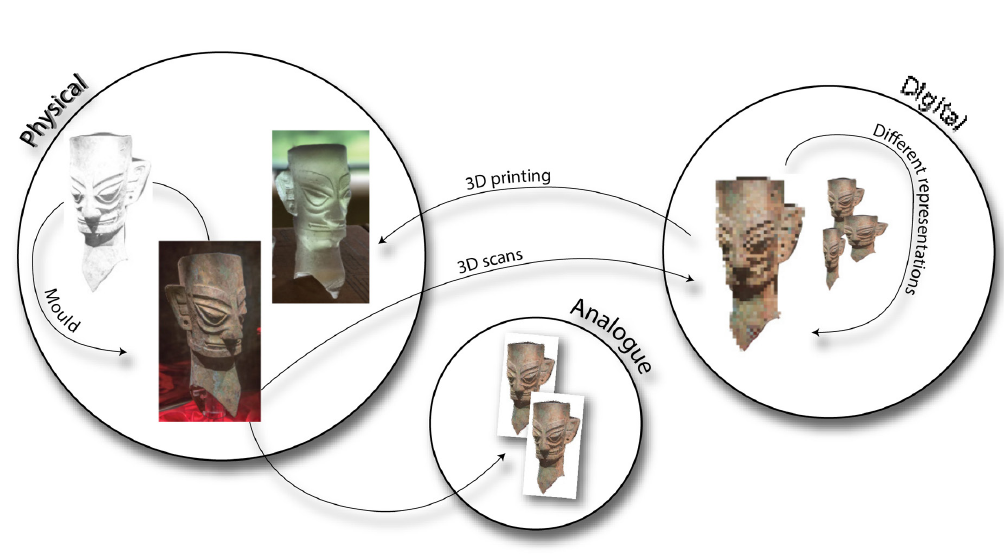
Fig. 1 A. Tomalini, Classification of possible reproductions in the fourth industrial revolution and their relationships according to Ch’ng (2019) , 2021, Digital